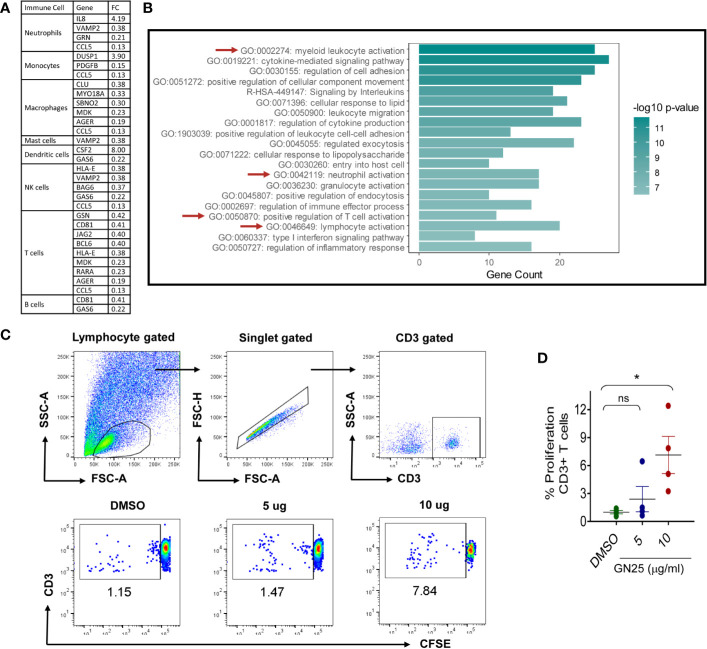
Most significantly enriched immune pathways within the immunomodulatory signature of GN25 (A). The differentially expressed genes (Fold changes cut-off >2 and <0.5) enriched in the gene ontology data sets for the activation and chemotaxis of each immune cell type (B). Pathway analysis of Differentially expressed genes enriched in the Immunome and activation/chemotaxis Gene ontology sets of each immune cell type. Pathway analysis done using Metascape (C). Representative FACS plots showing the percent of CFSE+ CD3+ cells co-culture with A549 cells treated with 5 and 10 µM GN25 as well as vehicle control (D). dotplot representation of mean percentage ± SEM of CD3+ cells proliferation in response to co-culture with A549 cells treated with 5 and 10 µM GN25 as well as vehicle control. Data shown are from four healthy individuals. * represents p-value <0.05.